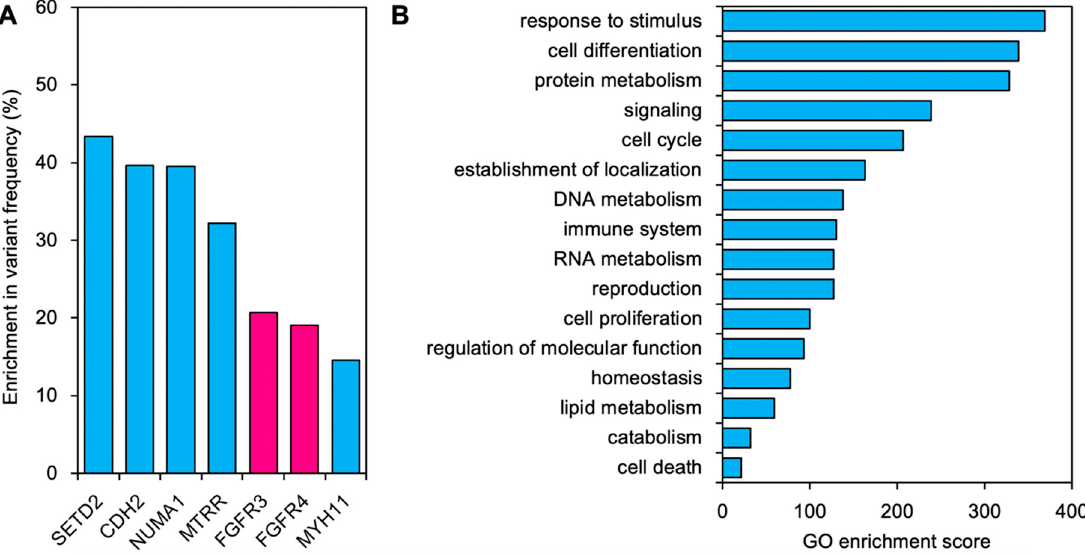
Figure 2. Enrichment analysis for somatic non-synonymous mutations comparing T2 with T1. A , Subtraction of VF T1 from VF T2 . The genes showing subtraction values >10% are listed. B , Sum of gene ontology (GO) enrichment scores for the genes listed in A (see Section 4.6 for the calculation of GO enrichment scores).